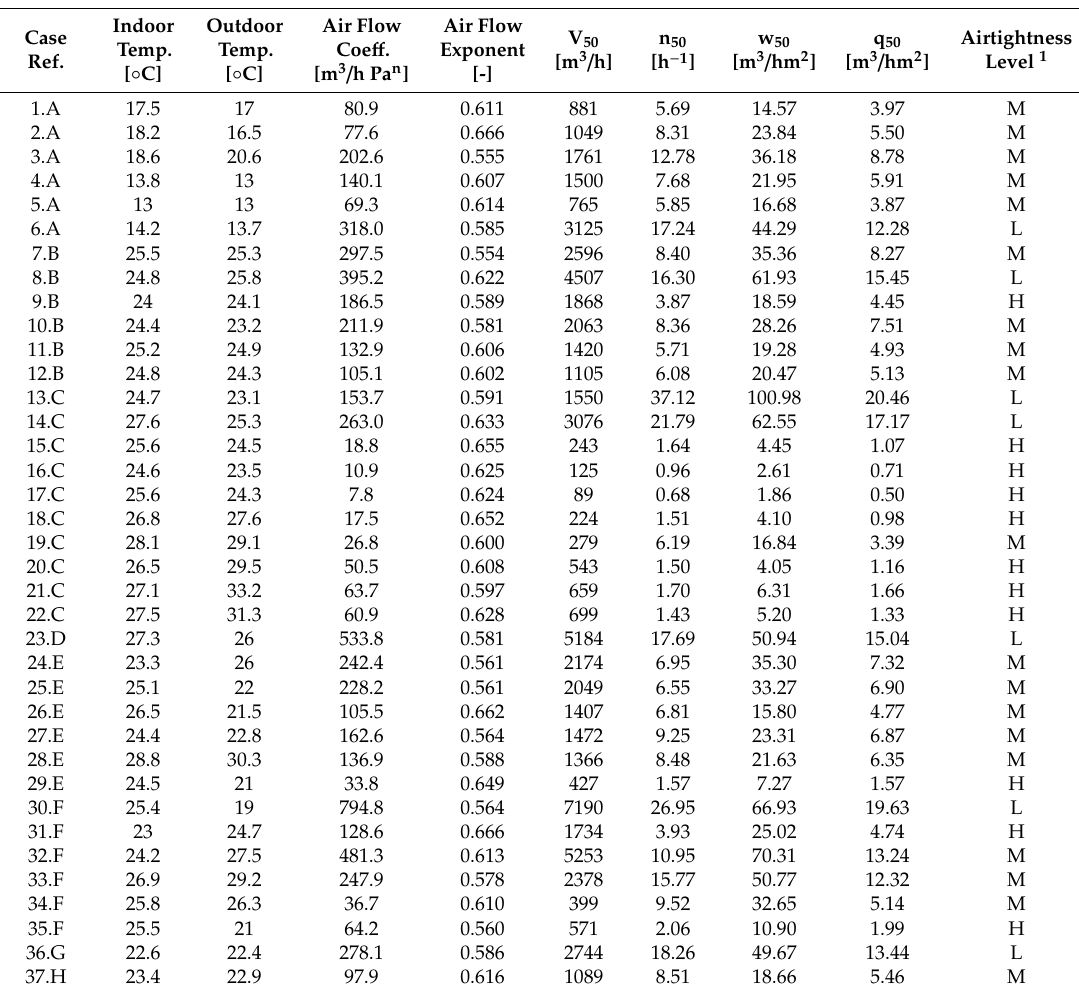
Table 6. Summary of the airtightness results of the tested enclosures. Case Ref.